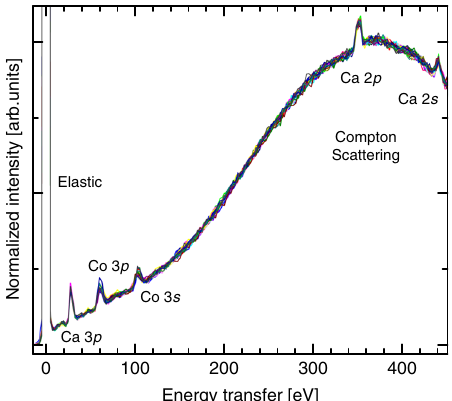
Fig. 2 Survey spectra of scans from all sample rotation angles. The energy was scanned from the elastic peak (9.69 keV) to 450 eV above it, in order to observe the Compton scattering pro fi le used for normalization. All calcium and cobalt absorption edges with core-level electron binding energies in the range can readily be seen. Of note is that dipole-forbidden Co 3 s ! 3 d transitions are